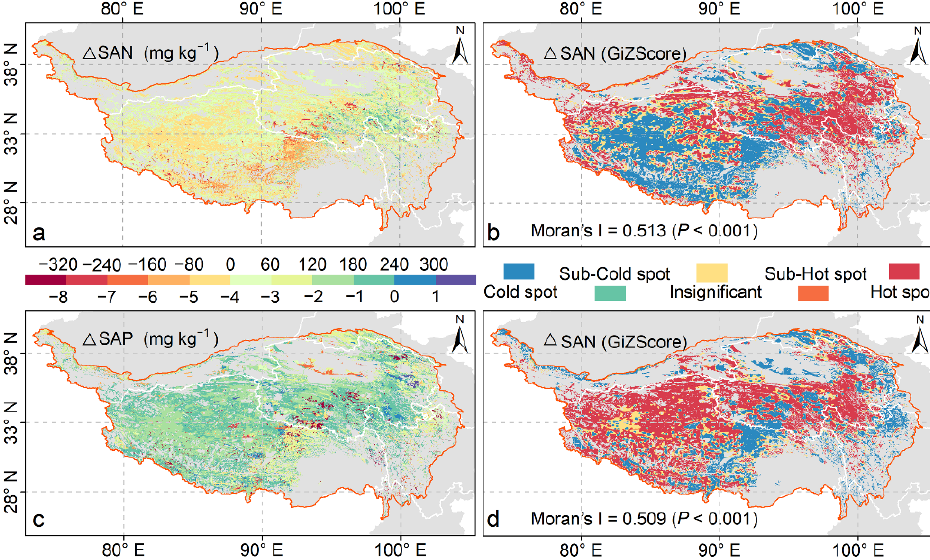
Figure 8. Spatial pattern and spatial autocorrelation of Δ SAN and Δ SAP: ( a , c ) denote the spatial distribution of Δ SAN and Δ SAP, respectively; ( b , d ) denote the spatial autocorrelation results of Δ SAN and Δ SAP, respectively.